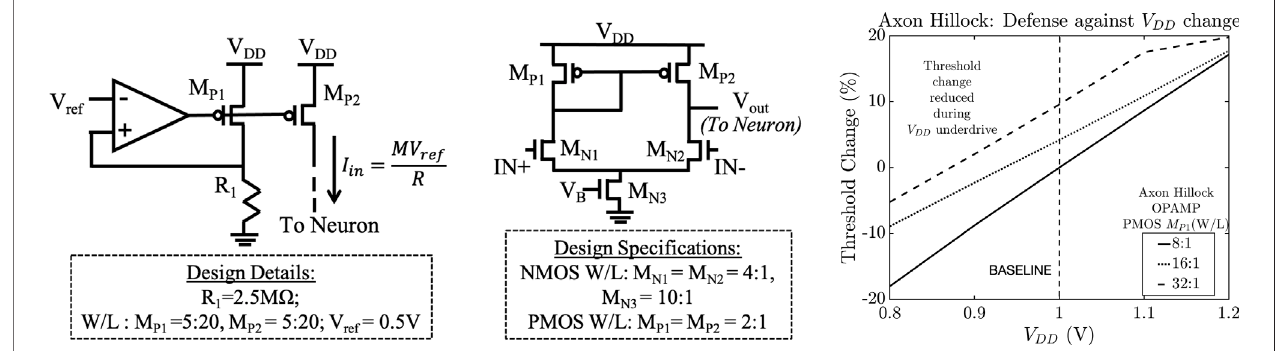
FIGURE 16 | (A) Robust SNN current driver (constant output spike amplitude); (B) comparator designed and implemented in the Axon Hillock neuron to mitigate threshold